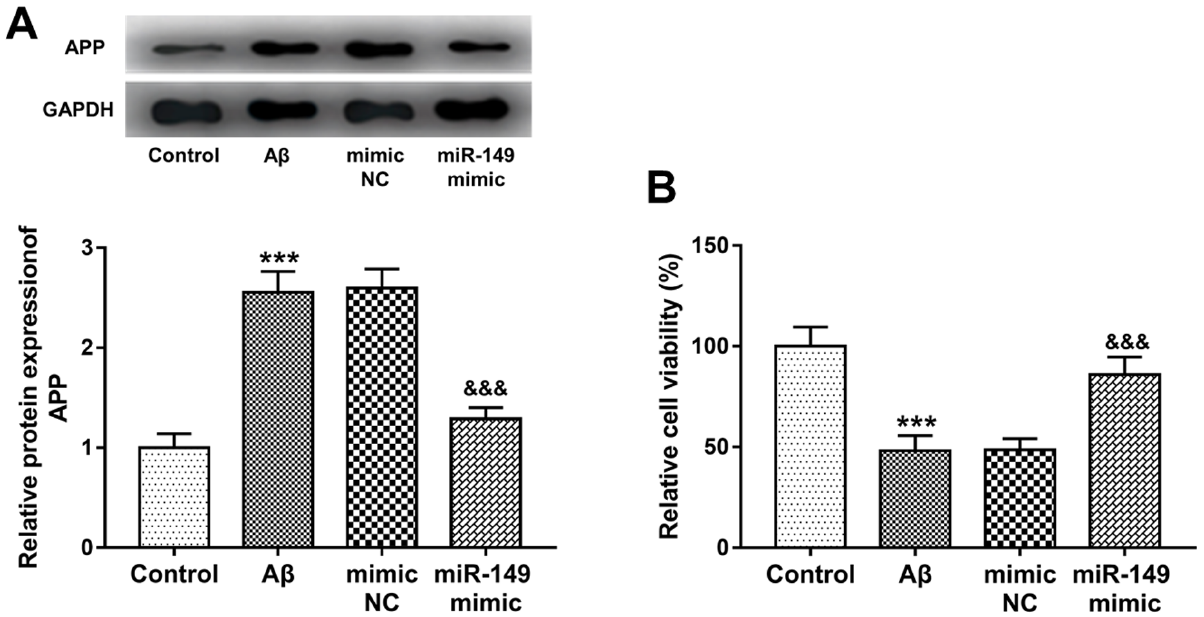
Figure 6 - Effect of miR-149 on Aβ accumulation and neuronal viability in Aβ-treated SH-SY5Y cells. A . The increased APP protein expression by Aβ treatment was reversed by the overexpression of miR-149. B . The decreased neuronal viability induced by Aβ was promoted by the upregulation of miR-149. *** P < 0.001 vs. Control; &&& P < 0.001 vs.